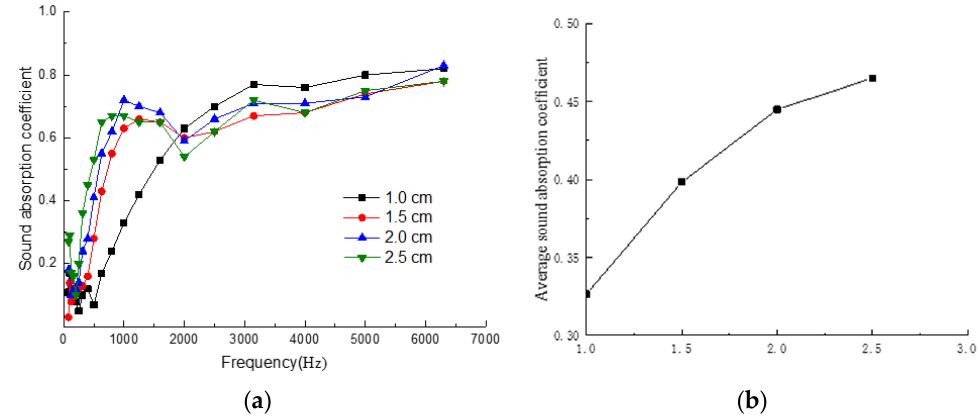
Figure 4. Influence of thickness on sound-absorption coefficient: ( a ) sound-absorption coefficient and ( b ) average sound-absorption coefficient .